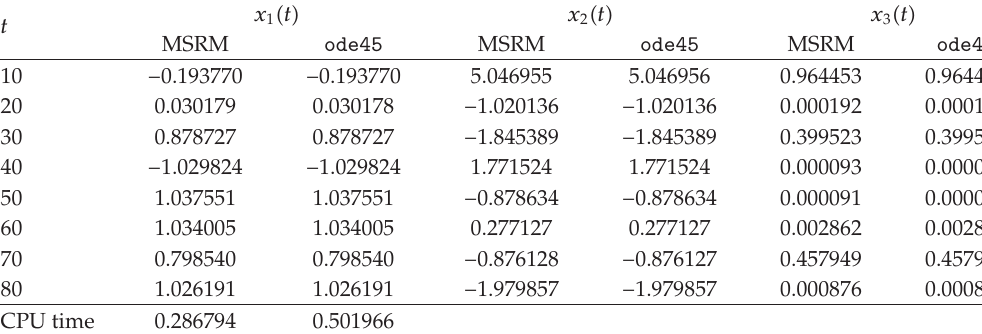
Table 5: Comparison of the numerical solution of Rabinovich-Fabrikant equations obtained by the MSRM and ode45 for a (cid:9) 0 . 1 and b (cid:9) 0 .